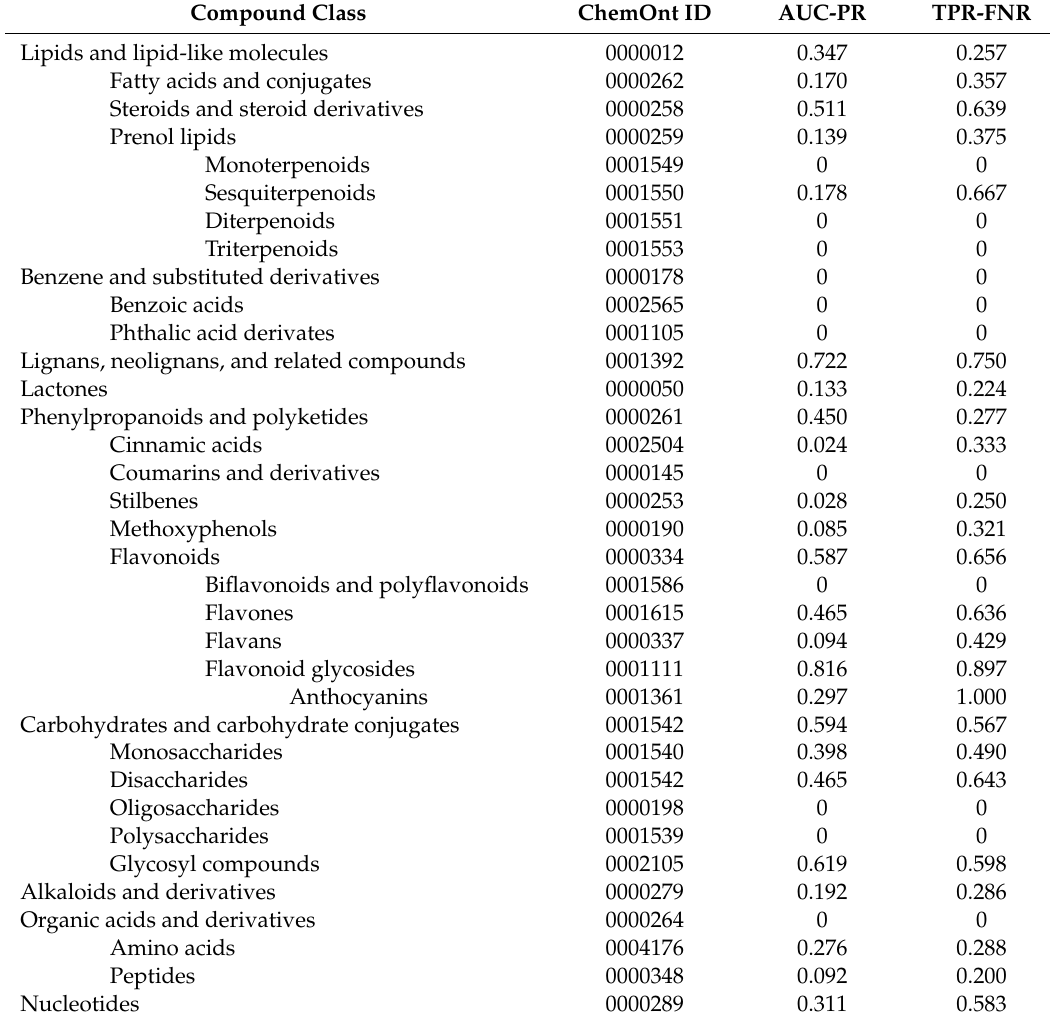
Table 1. List of classified compound classes and the corresponding area under precision–recall curve (AUC-PR) and the true positive rate for a fixed false negative rate of 5% (TPR-FNR) determined by our classifier in all of the bryophyte samples. The higher the AUC-PR value the better was the performance of the classifier. Generally, values above 0.5 are considered to be a good performance metric with imbalanced data [53]. The higher the TPR-FNR the larger was for the probability that the classifier assigned chemical entities correctly to a compound class. A value of 0 means for both metrics that the classifier could not assign enough spectra to a particular compound